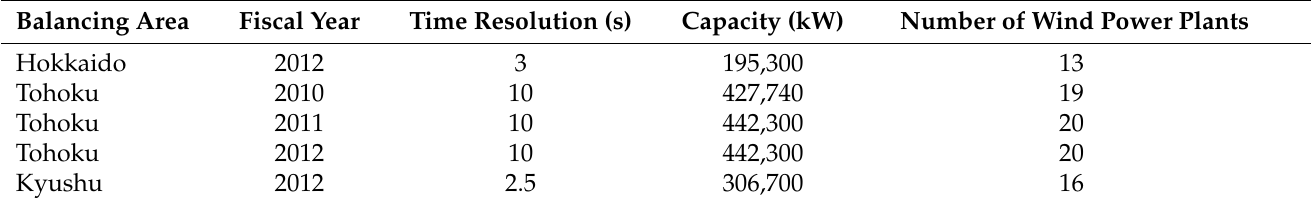
Table 1. Historical wind power output data for the Hokkaido, Tohoku, and Kyushu areas. Balancing